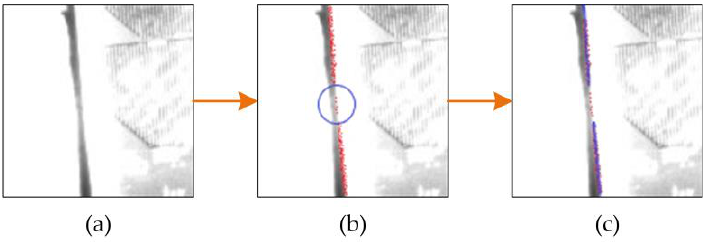
Figure 5. False alarm caused by anchor density change. ( a ) The original image. ( b ) Errors in anchor map extraction. ( c ) The complete line segment is divided into two small line segments.